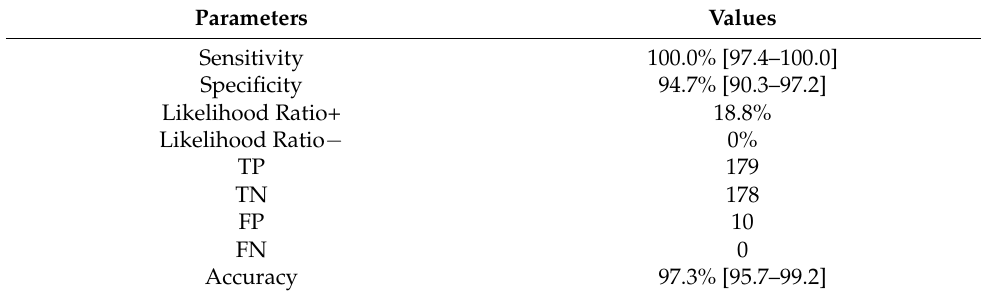
Figure 3. True positive (TP), true negative (TN), false positive (FP), and false negative (FN) propor- tions. Table 4. Performance characteristics at 0.208.